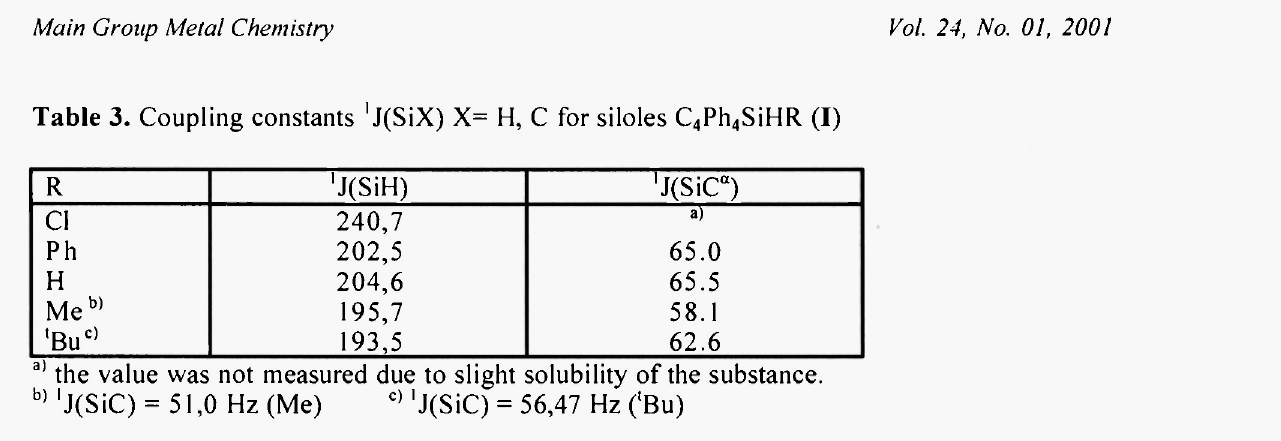
Table 3. Coupling constants 'j(SiX) X= H, C for siloles C 4 Ph 4 SiHR